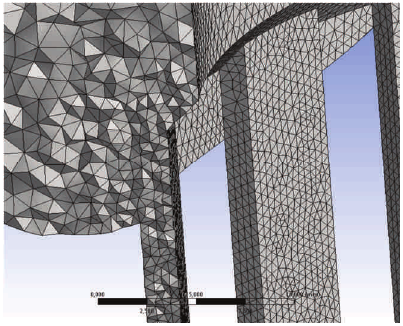
Fig. 4. Cross-section of computational grid of fluid jacket model, with a minimum element size of 0.4 mm